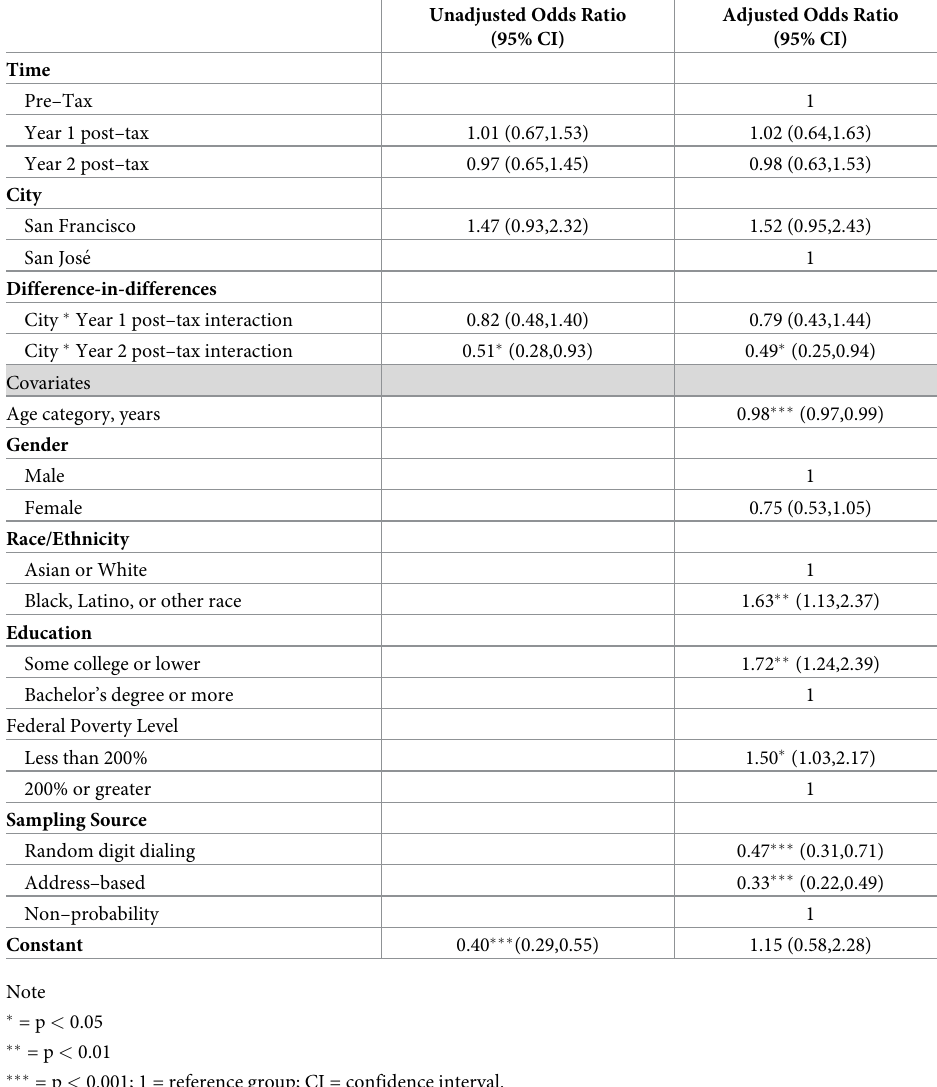
Table 3. Difference-in-differences of likelihood of high sugar-sweetened beverage (SSB) consumption a pre- and post-tax implementation between San Francisco and San Jose´ (n =